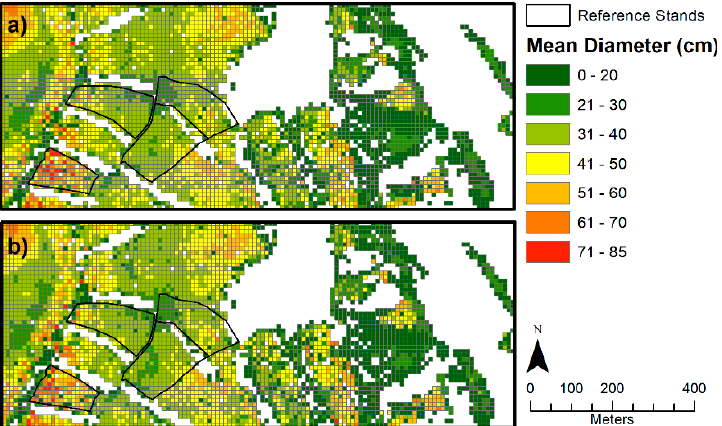
Figure 4. Maps of mean diameter over grid cell (10 × 10 m): ( a ) Multisource-based method and ( b ) raster-based method.